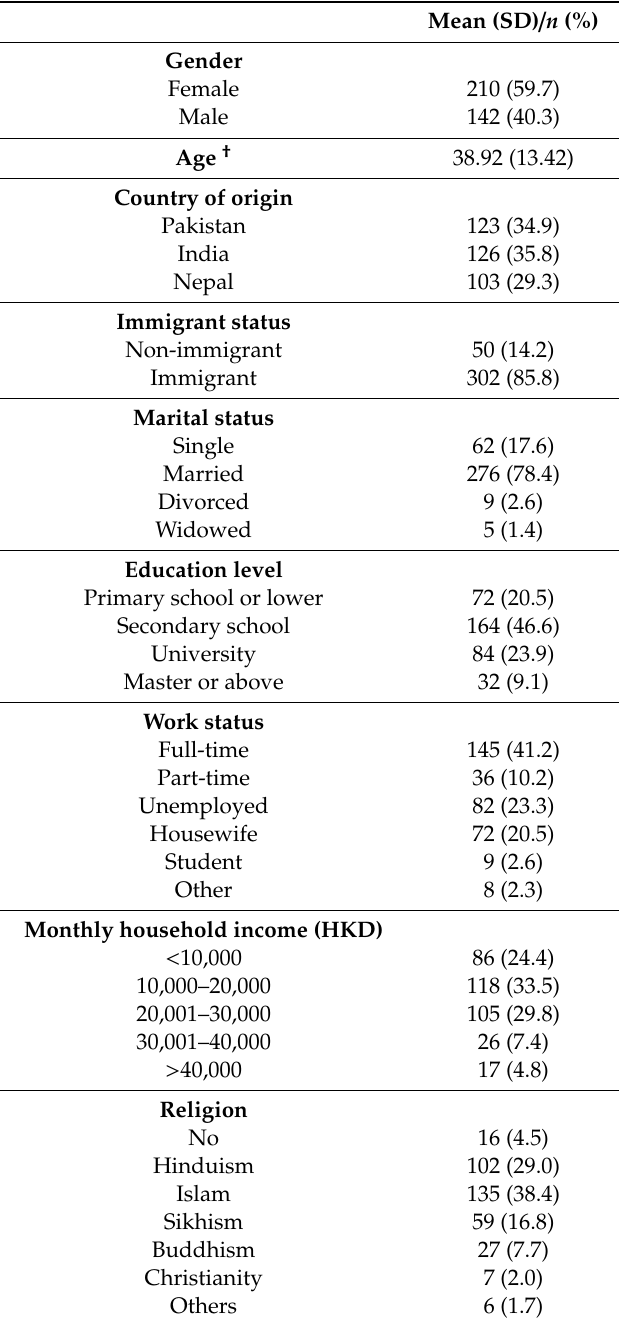
Table 1. Sample characteristics ( n =